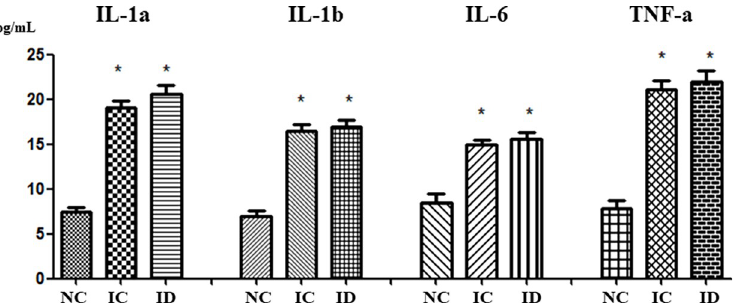
Fig 6. The concentrations of the pro-inflammatory cytokines (interleukin [IL]-1 α , IL- β , IL-6, and tumor necrosis factor [TNF]- α ) in brain homogenate taken from the periventricular area on day P32. The numbers are expressed as the mean ± SEM. IVH refers to intraventricular hemorrhage. � P < .05 compared to the normal control (NC, n = 5). IC, IVH control (n = 10); ID, IVH + dexamethasone (n =